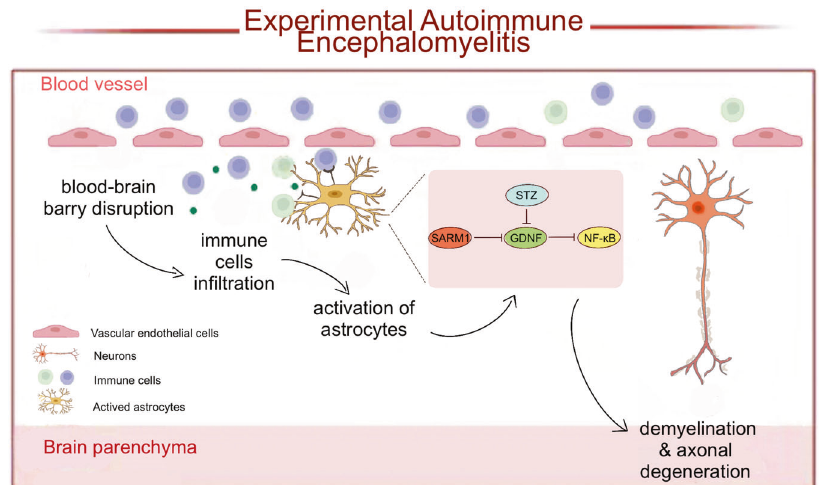
Fig. 8 A working model of astrocytic SARM1 ’ s function in EAE mice. SARM1 is upregulated in the astrocytes of spinal cords in EAE. Astrocytic SARM1 inhibits the expression of GDNF, which promotes the neuronal death, neuroin fl ammation and demyelination in EAE through NF- κ B